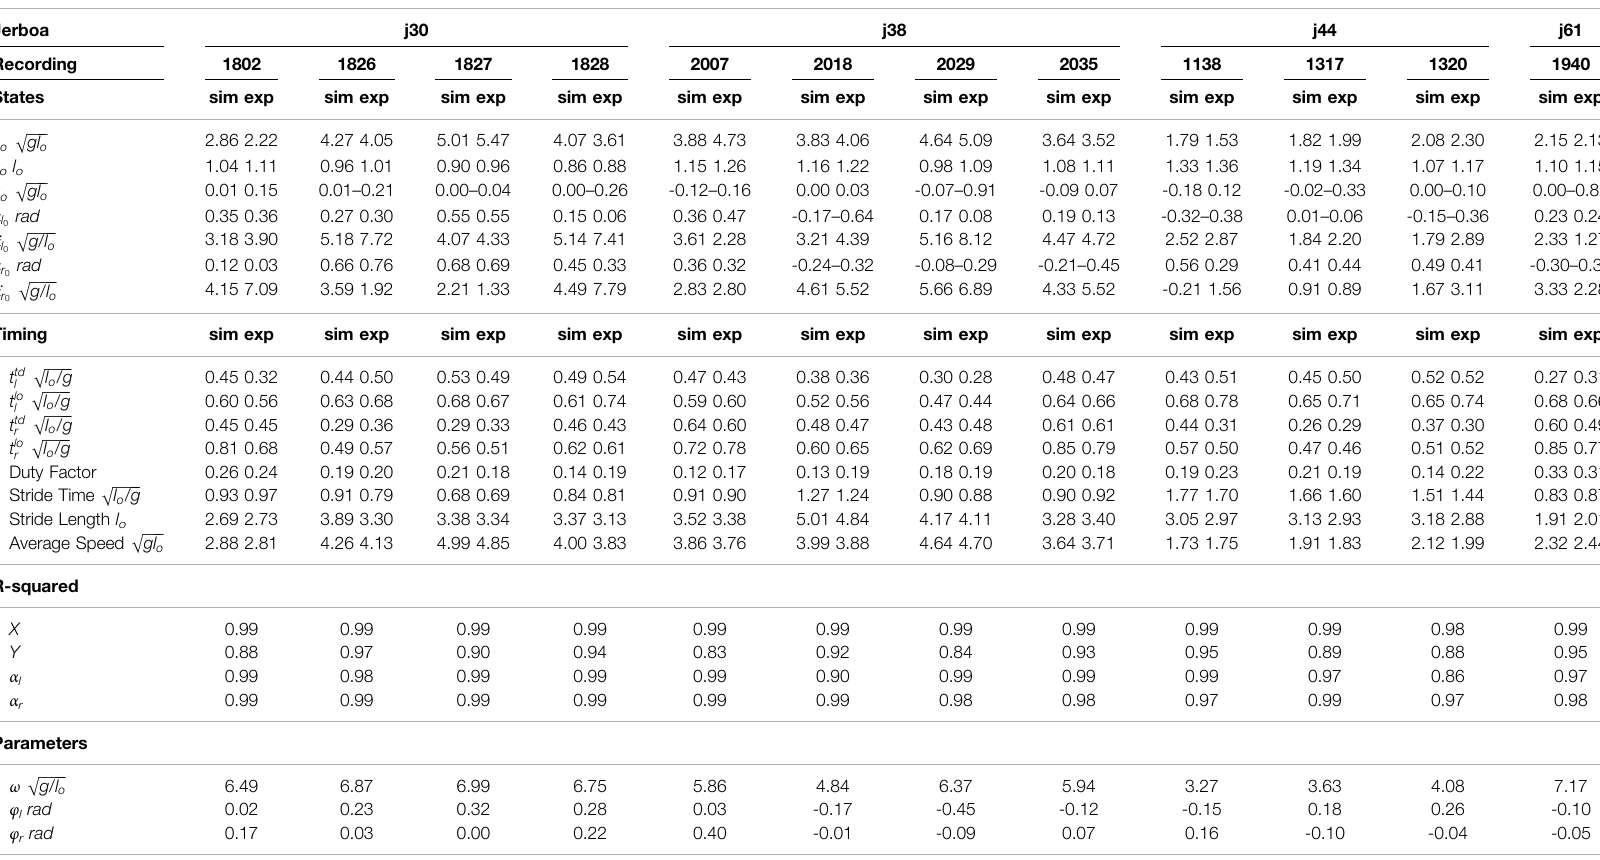
TABLE 1 | Optimized initial states and system parameters of the proposed model associated with all 12 empirical trials of jerboa skipping locomotion are listed in this table. The optimized trajectory of trial 1802-j30 corresponds to Figure 2 . All states and parameters are normalized with respect to the total mass of the system, m , the uncompressed leg length, l o , and the gravity on Earth, g . Jerboa j30 j38 j44 j61 Recording 1802 States (cid:1)(cid:1)(cid:1) (cid:3) _ x gl o o y o l o